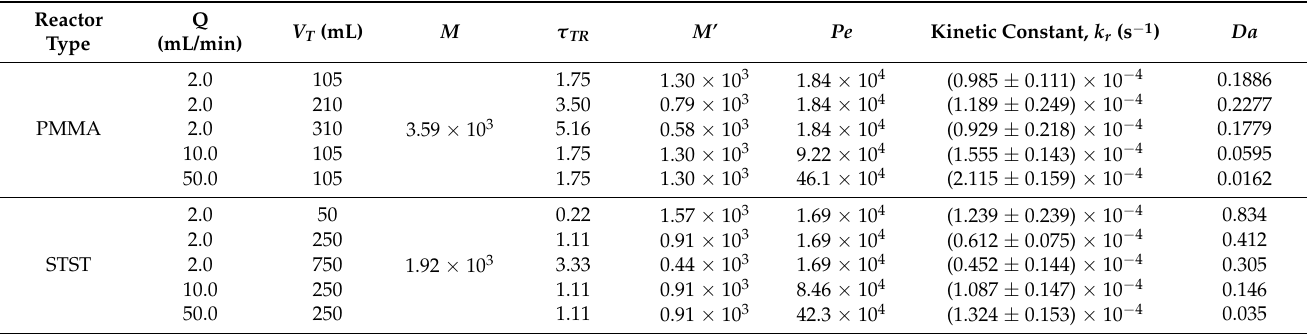
Table 5. Dimensionless parameters of flow-through experiments and estimated values of reaction kinetic